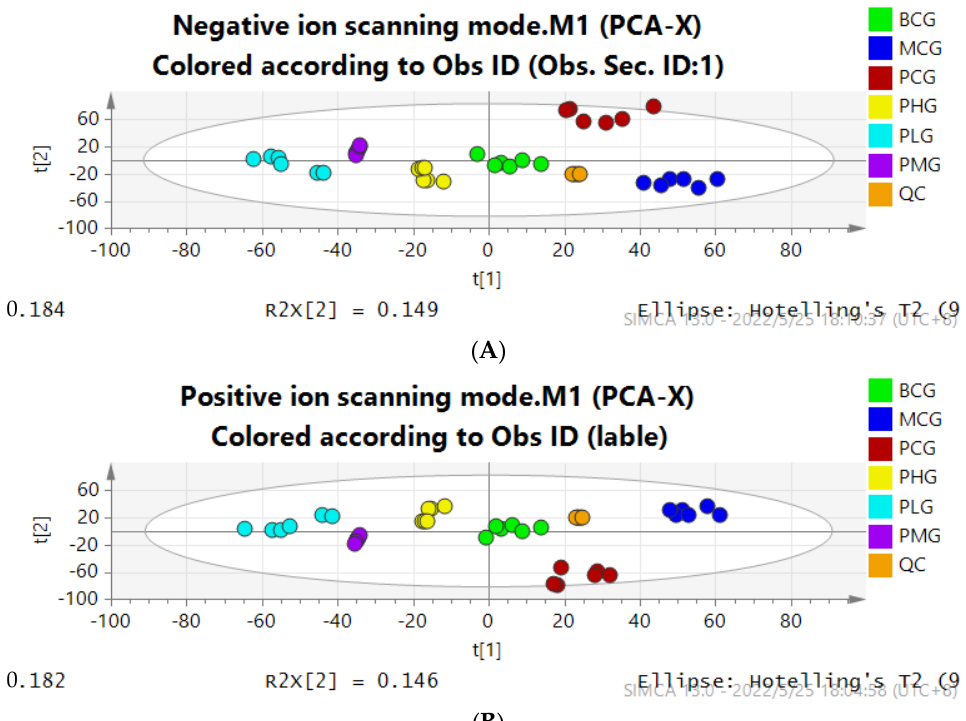
Figure 3. PCA score map of liver tissue in each group (( A ): Negative ion mode; ( B ): Positive ion mode).